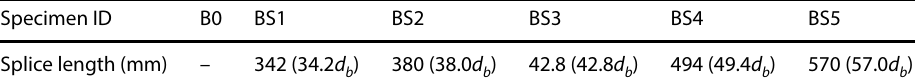
Table 3 Variation of splice